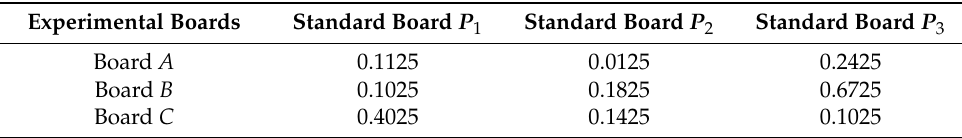
Table 6. The Euclid distance between the experimental boards and standard boards. Experimental Boards